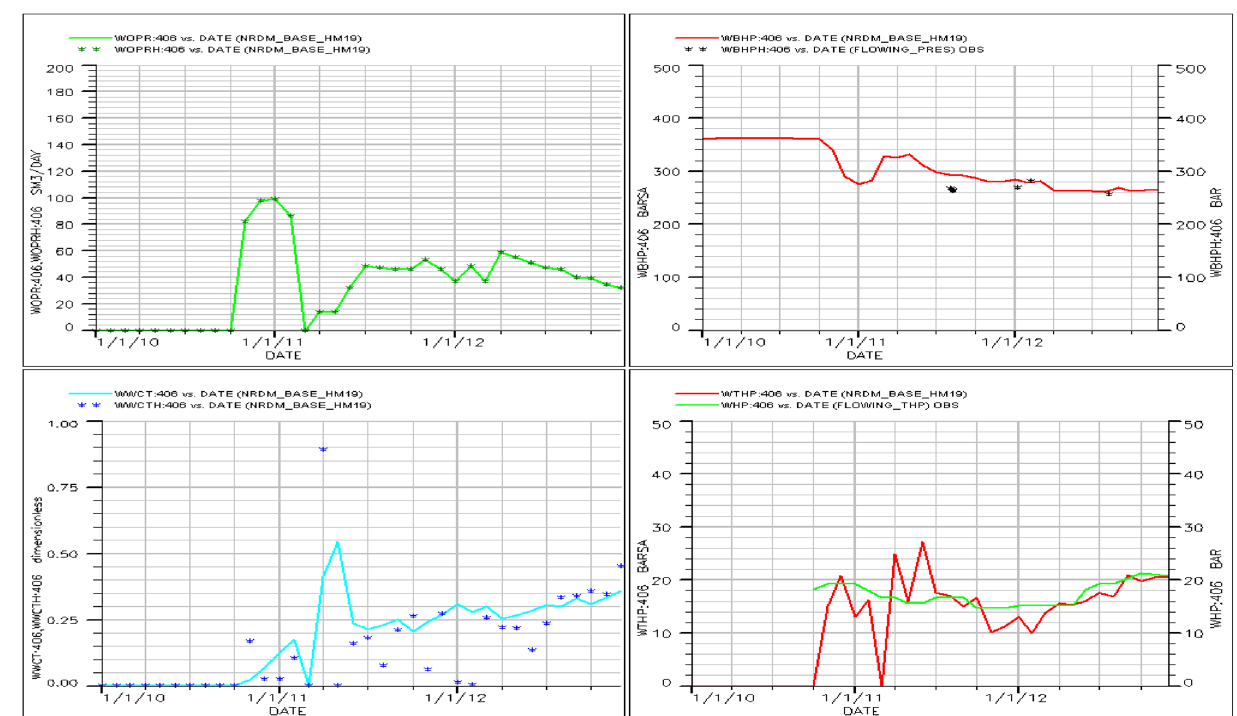
Fig. 9 Matching results of well